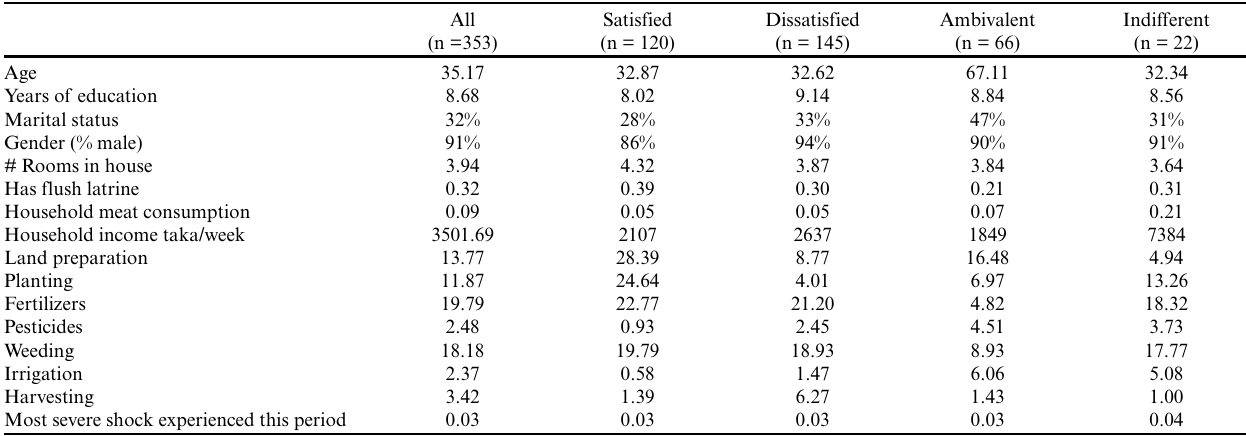
Table 2 . Summary statistics showing characteristics of different RLS-Over-Time groups. Numbers for agricultural activities represent person-hours per week of household labor spent in this activity. Scale for reporting shocks: 0 – none; 1 – low impact; 2 – medium impact; 3 – high